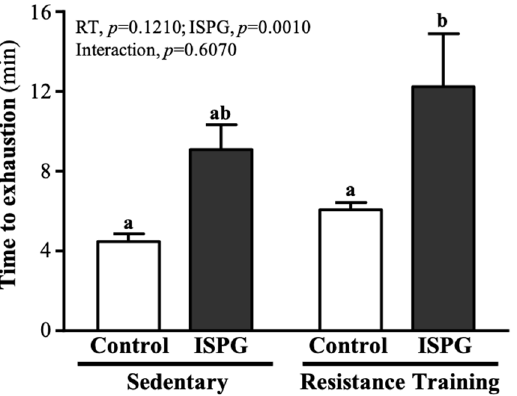
Figure 4. Effect of ISPG and resistance training on exhaustive swimming time. Data are expressed as the mean ± SEM of 8 mice/group. Different superscript letters (a, b) above the bar are significantly different at p < 0.05. If any letter is the same, it means that the difference between groups is not significant.